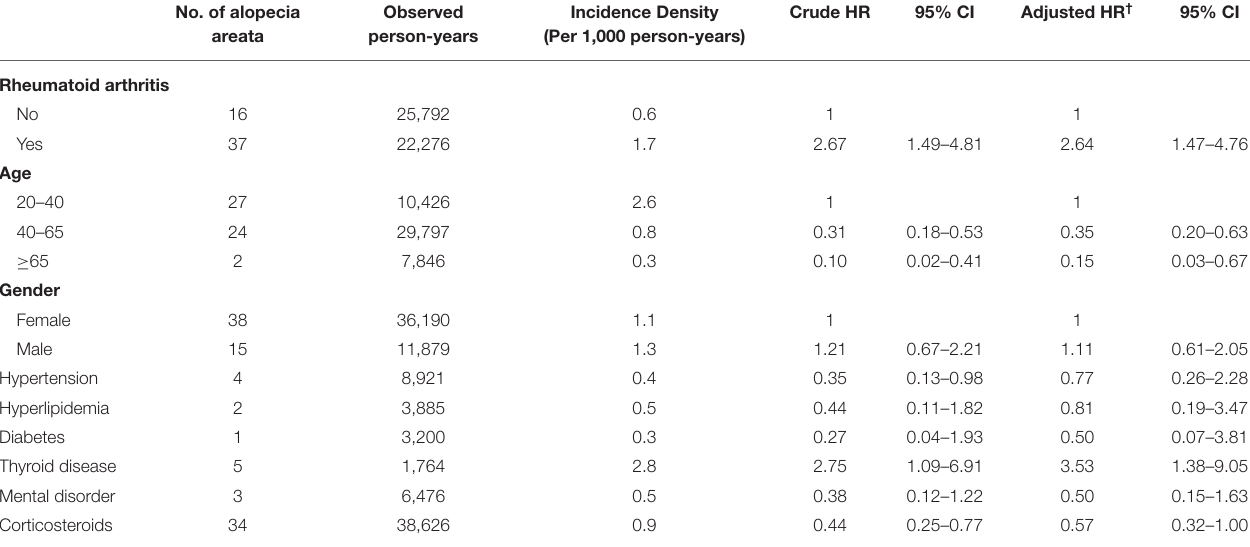
TABLE 2 | Comparison of incidence and HR of alopecia between patients with and without rheumatoid arthritis by Cox proportional hazard model. No. of alopecia Observed Incidence Density areata person-years (Per 1,000